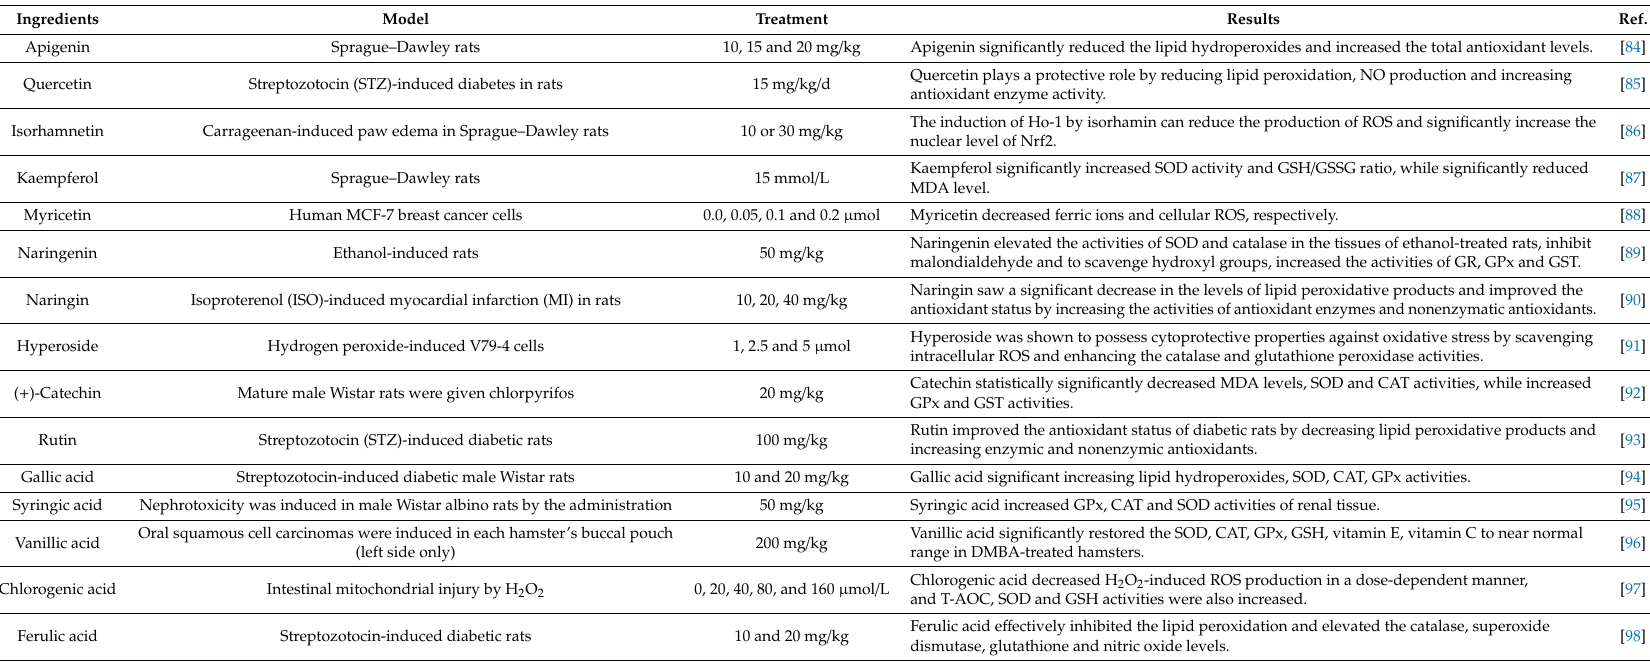
Table 5. Antioxidant activities of phenolic acids in Hippophae